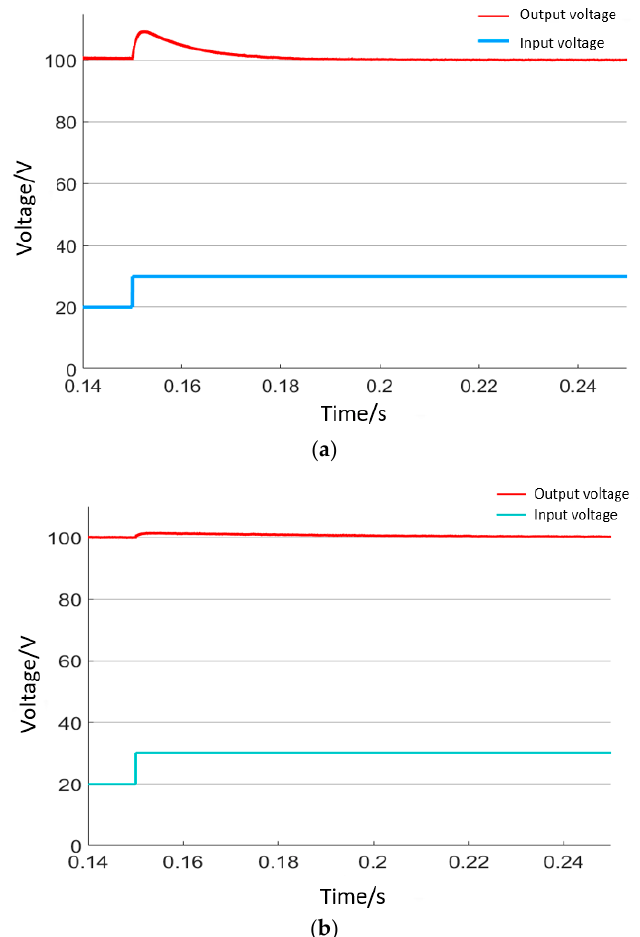
Figure 13. Output voltage response when two different control strategies are used to handle input voltage disturbance. ( a ) Voltage feedback control system; and ( b ) feedforward-double feedback control system.